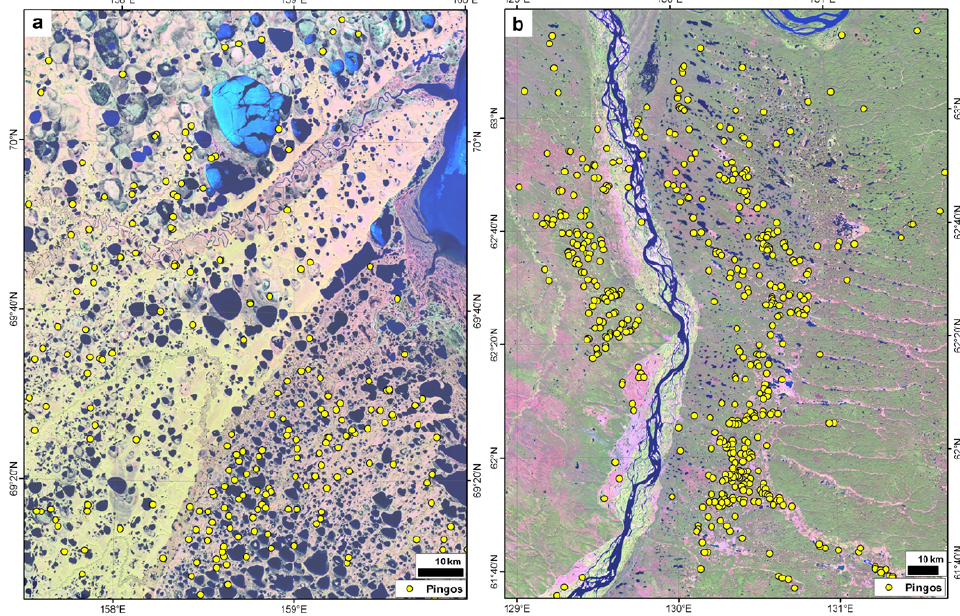
Fig. 6. Local subsets of the pingo distribution in the Kolyma Lowland region (a) and the region north of Yakutsk, central Siberia (b) . The distribution of pingos in both subregions seems clearly related to lithology, hydrology, and local permafrost conditions. In (a) , pingo distribution is dense and possibly aligend with abandoned paleochannels of the Kolyma River in the Khalertchinskaya Tundra (lower right corner of image), whereas pingo distribution is loose and widespread in the region dominated by Yedoma and large drained lake basins (left and upper left corner). In (b) , pingos are clearly aligned with fluvial terraces of the paleo-Lena River east and west of the modern Lena River. Also, there is a clustering of pingos at locations where elongated thermokarst (alas) valleys enter the paleo-Lena terraces from the east. For location of the subsets see Fig. 2. In both subsets the background image is a false color composite from Landsat-ETM+ with RGB bands 5-4-3 from the mid-summer season (data provided by USGS EROS Data Center).